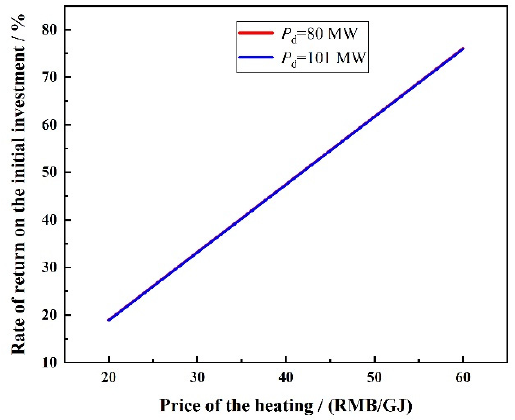
Figure 15. Rate of return on the initial investment vs. the price of heating.